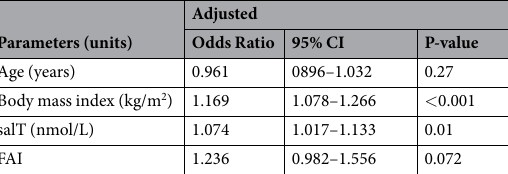
Table 4. Multiple logistic regression analysis for the androgen prediction of PCOS including age, body mass index, salivary testosterone and free androgen index. Logistic regression taking into account age and body mass index (BMI) showing that in this model salivary testosterone (salT) is significantly more predictive of PCOS than the free androgen index (FAI) or serum T (Tables 5 and 6, respectively), and that FAI was more predictive than serum T (C).